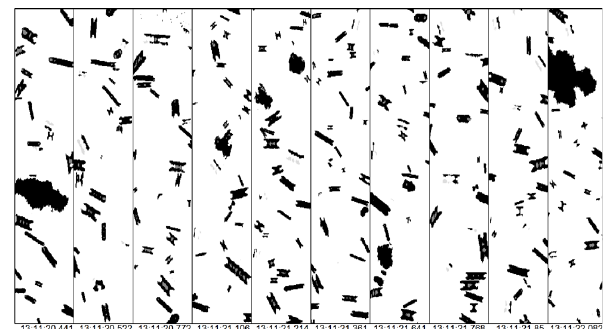
Fig. 11a. Particle images from the 2DS probe. Each image strip is approximately 1.28mm wide and 12.8mm long. Data are from R2 ( T =− 11 . 7 ◦ C, altitude = 3.48km) in the supercooled layer cloud above CFARR.